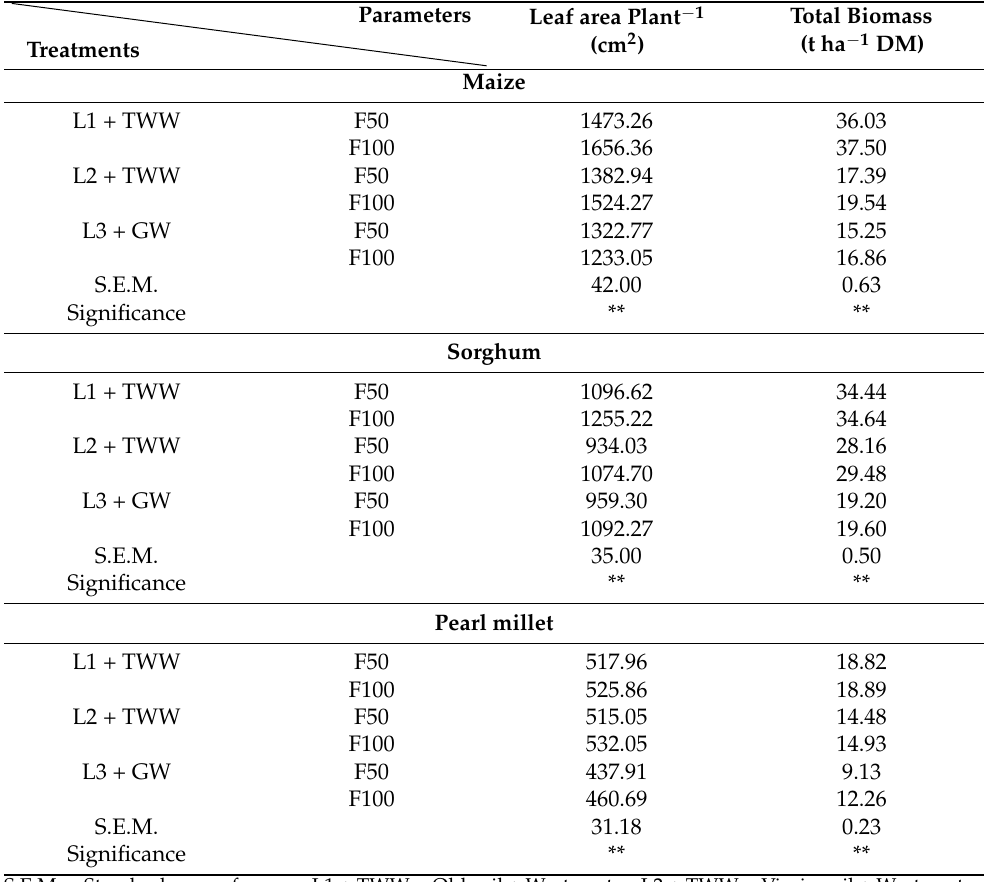
Table 5. Interaction effects of water resources and fertilization treatments on leaf area per plant and total biomass of maize, sorghum, and pearl